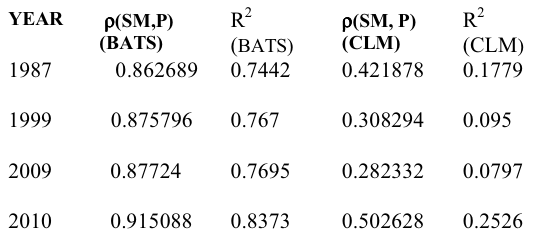
Table 2. Correlation (averaged over central India) and R 2 between soil moisture and precipitation using BATS and CLM scheme for El Niño (1987,2009), La Niña (1999,2010) years . The soil moisture precipitation feedback parameter λ NC (SM, P) is used to access the contribution of soil moisture-precipitation coupling. The RegCM4.0 enabled BATS scheme shows higher values of soil moisture-precipitation feedback in comparison to RegCM4.0 enabled CLM scheme. (See Figure 8. and Figure